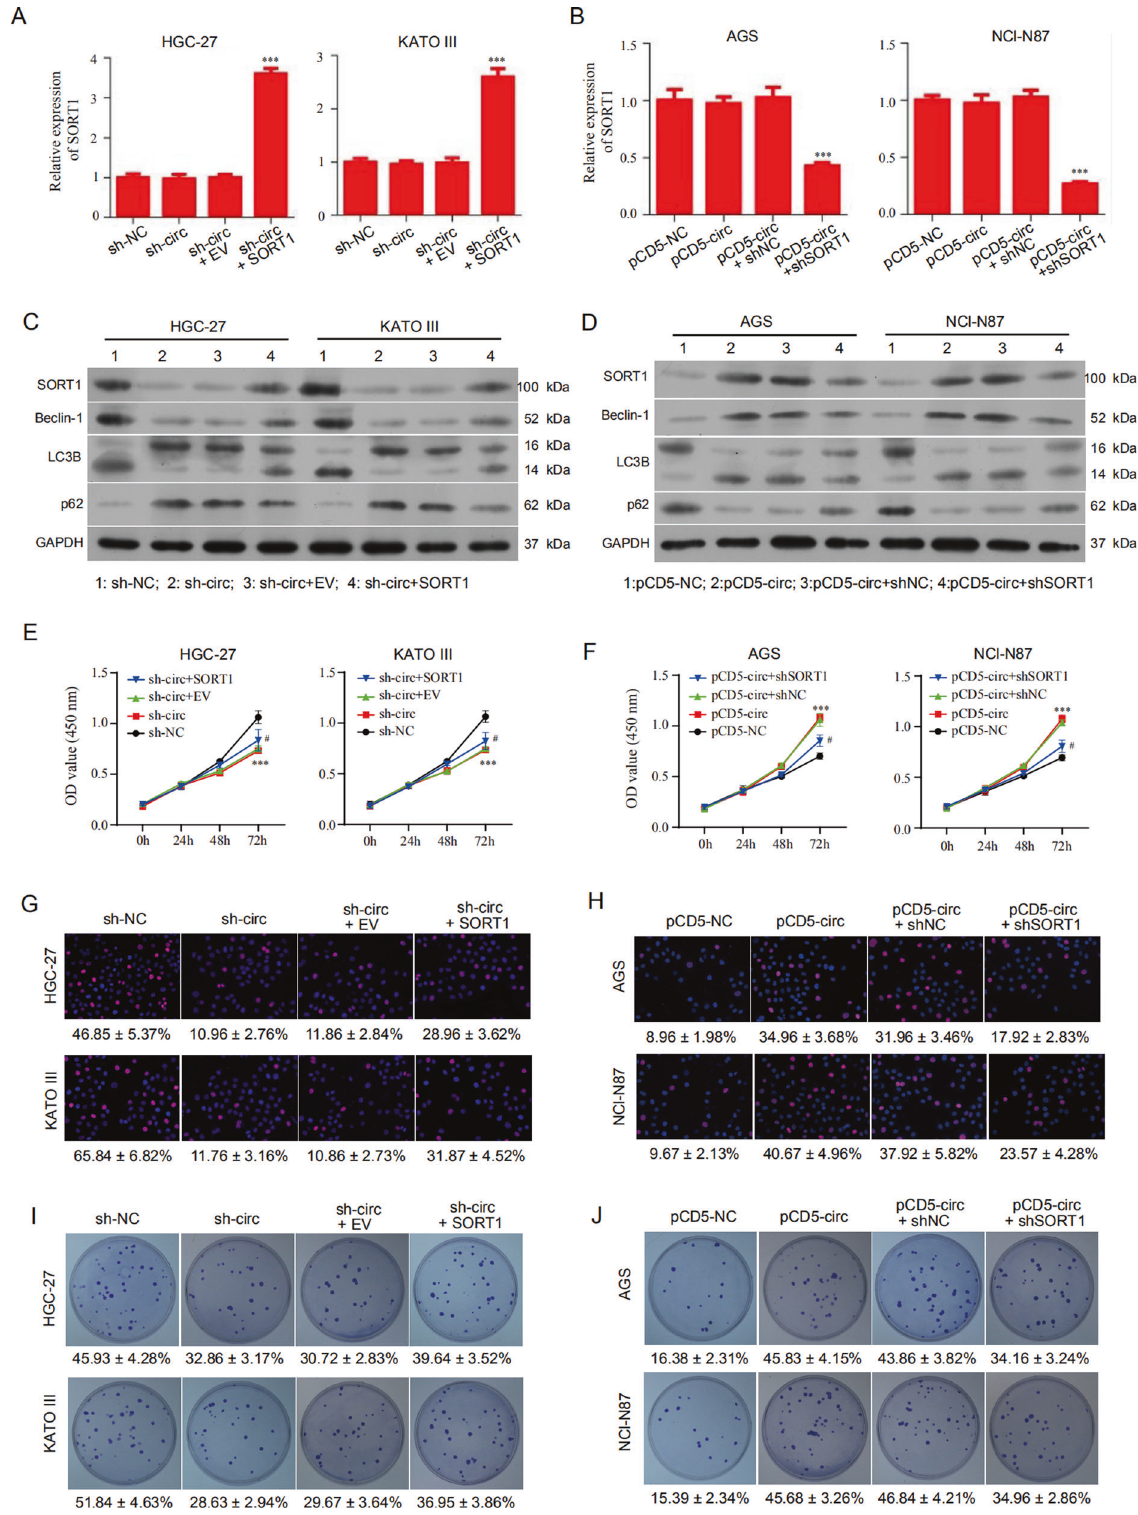
Fig. 6 Hsa_circ_0110389 promotes the proliferation of GC cells through SORT1. A , C , E , G , I HGC-27 and KATO III cells were transfected with sh-NC, sh-circ, sh-circ + EV or sh-circ + SORT1. Then the relative mRNA and protein expression of SORT1 was respectively measured by qRT-PCR analysis ( A ) and western blot assays ( C ), and the ability of cell proliferation and growth was assessed by CCK-8 assay ( E ), EdU assay ( G ) or colony formation assay ( I ). B , D , F , H , J AGS and NCI-N87 cells were transfected with pCD5-NC, pCD5-circ, pCD5-circ + shNC or pCD5-circ + shSORT1. Then the relative mRNA and protein expression of SORT1 was respectively measured by qRT-PCR analysis ( B ) and western blot assays ( D ), and the ability of cell proliferation and growth was assessed by CCK-8 assay ( F ), EdU assay ( H ) or colony formation assay ( J ). C , D The protein levels of autophagy-related genes (Beclin-1, LC3B and p62) were also analyzed by western blot assays. All data are presented as mean ± SD. EV empty vector. *vs sh-NC/pCD5-NC group, #vs EV/shNC group. ** p < 0.01, *** p < 0.001, ## p < 0.01, ### p < 0.001. Cell Death and Disease (2021)